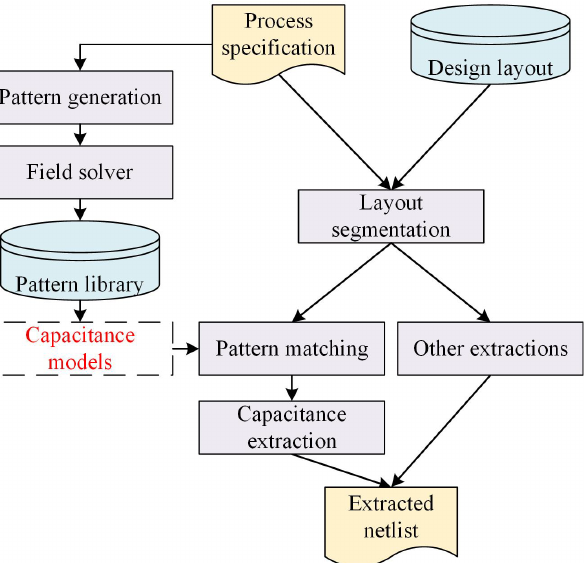
Figure 1. The flow of parasitic capacitance extraction using the pattern-matching method